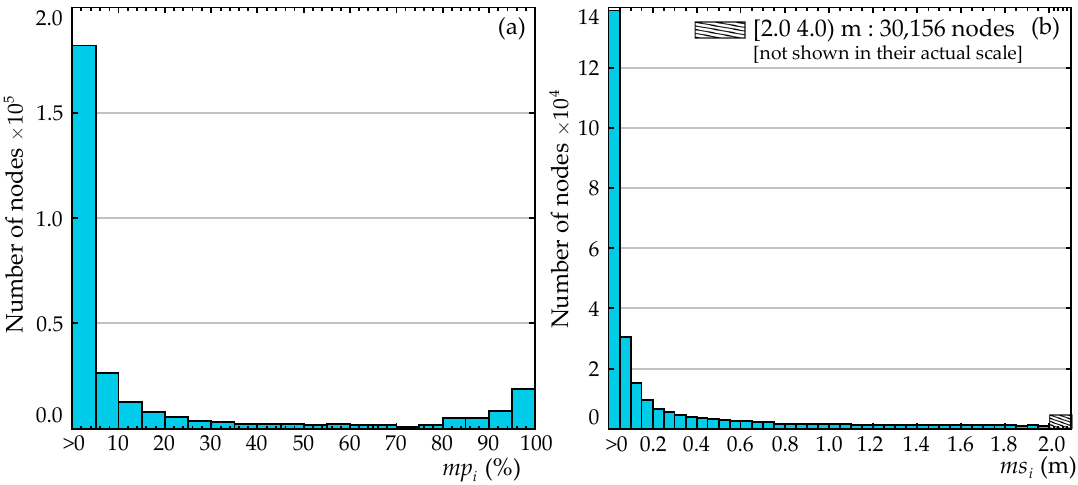
Figure 7. Histogram of the surge gap for the population of problematic nodes.